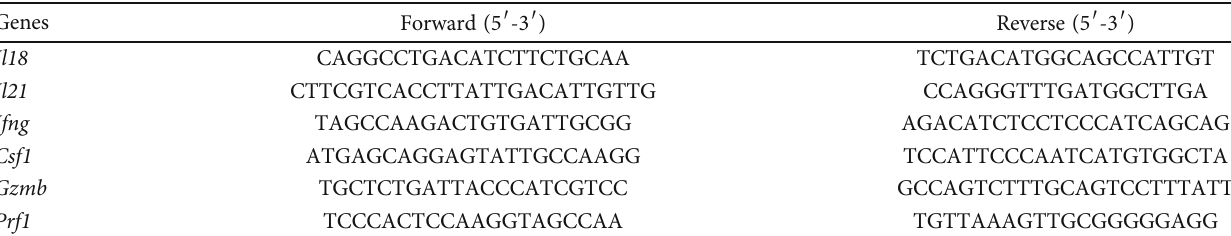
Table 1: Real-time PCR primers used in this